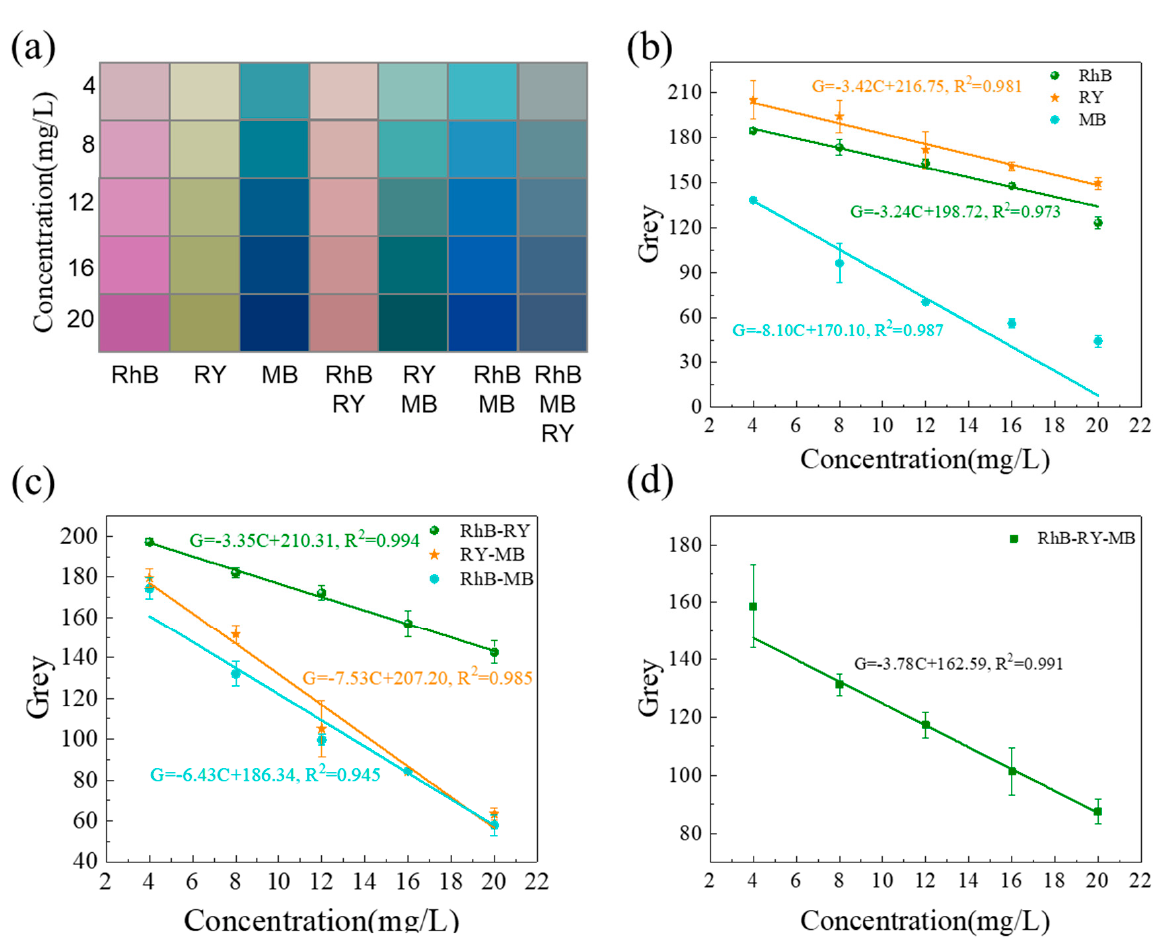
Figure 1. ( a ) Color blocks for different dye samples measured by the PMTs method, and standard curve fitting for greyscale values obtained from ( b ) RhB, RY, and MB solutions, ( c ) RhB-RY, RY-MB, and RhB-MB solutions, and ( d ) RhB-RY-MB solution.